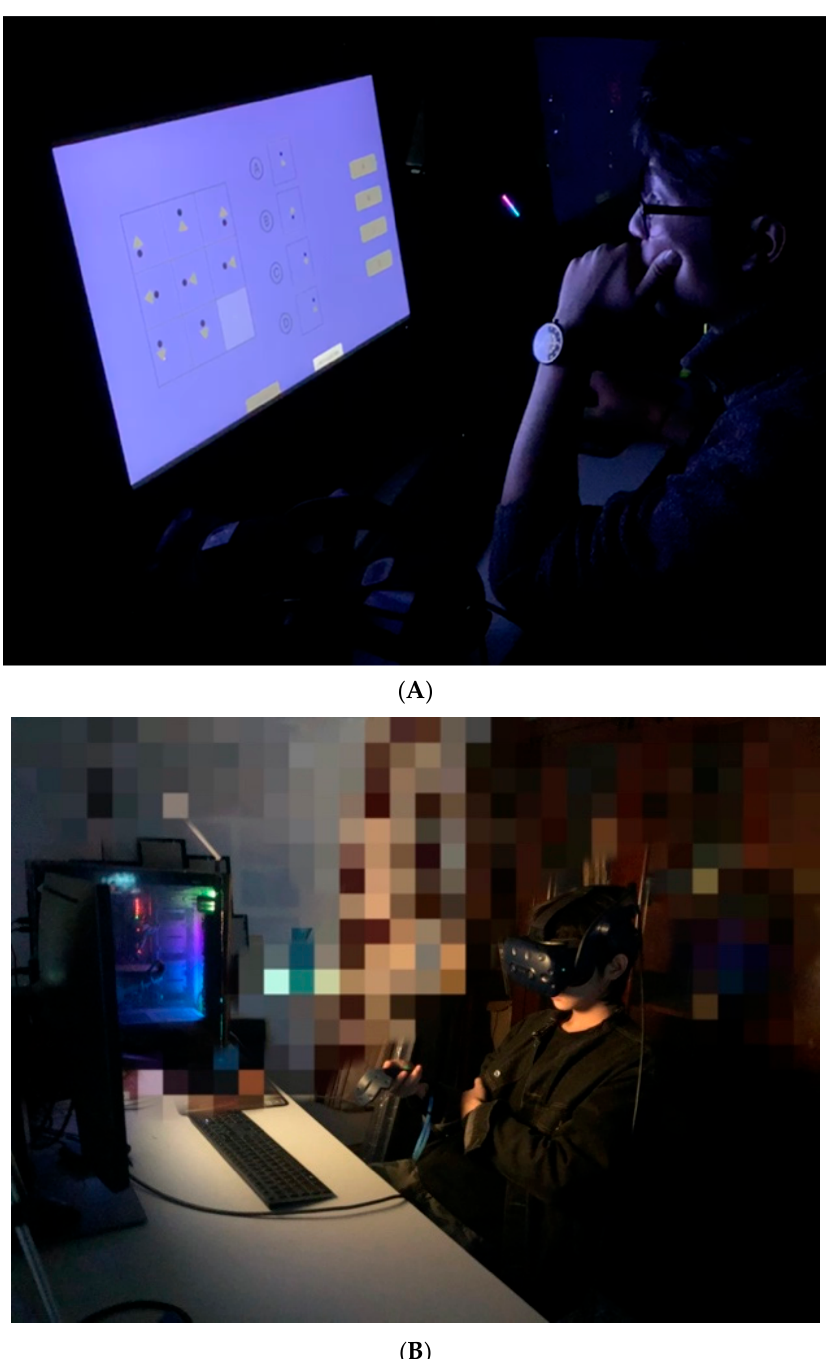
Figure 1. ( A ) Individual participant using the mouse to complete each question; ( B ) individual participant performing psychometric tasks using HTC Vive VR headset.